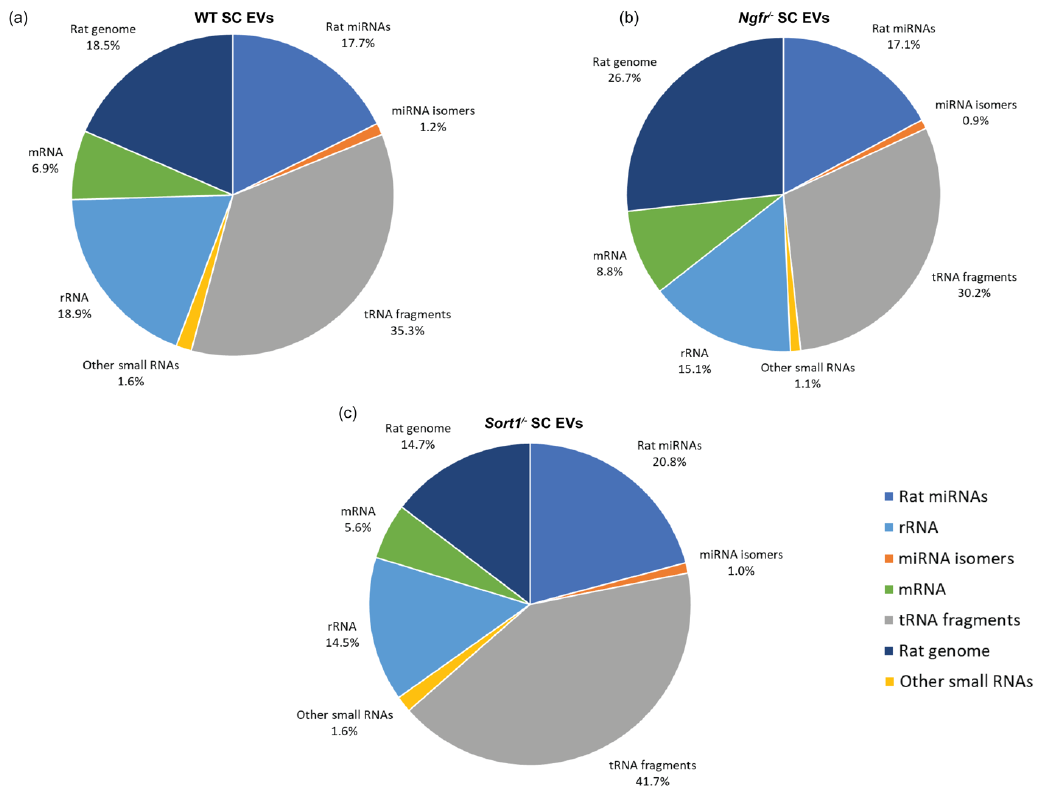
Figure 3. The read mapping distribution for the three types of Schwann cells (SCs) analyzed: ( a ) WT, ( b ) Ngfr −/− and ( c ) Sort1 −/− SCs. The tRNA category includes all types of tRNA fragments.